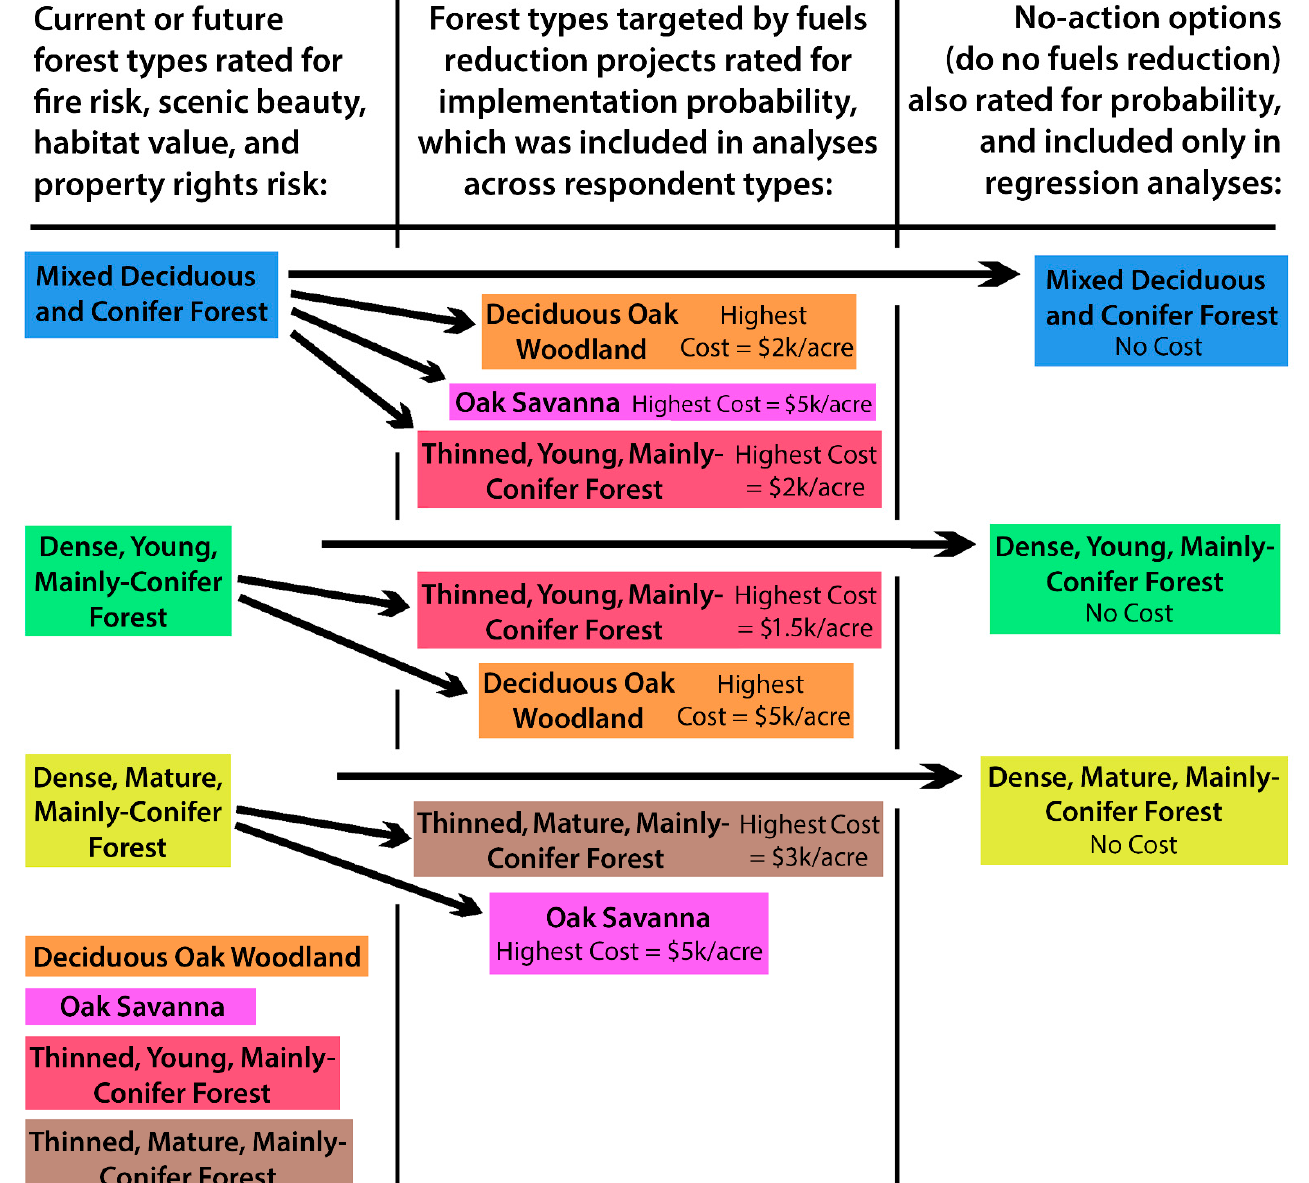
Figure 1. Structure and costs of fuels reduction project options in the study.